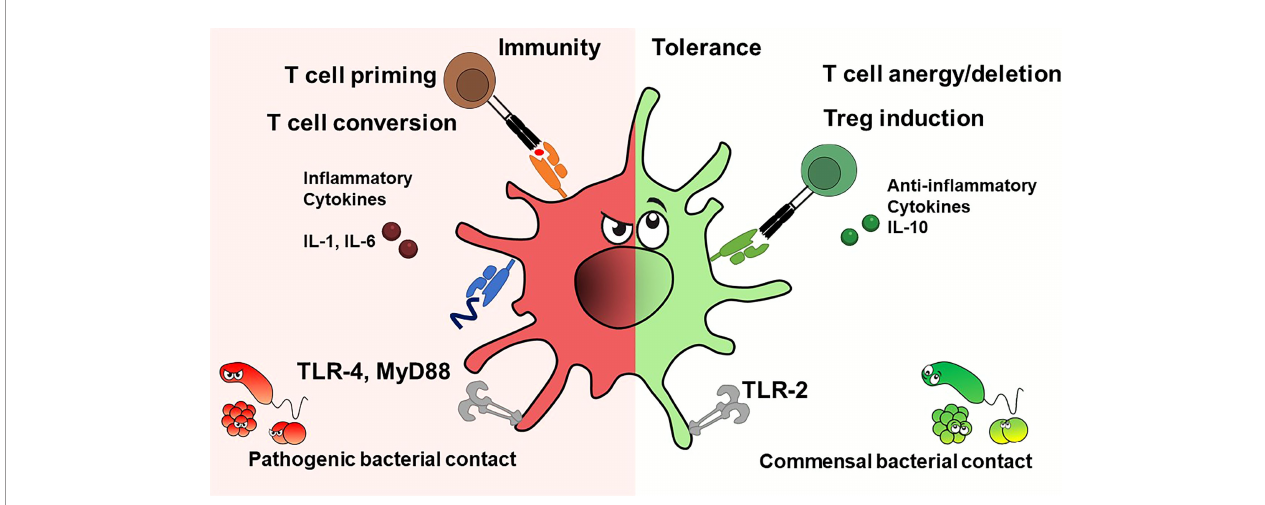
FIGURE 1 | Dendritic cells exhibit immunostimulatory or tolerogenic potential depending on the context. DC's fate depends on cytokines and pathogen contact. In fl ammatory cytokines and pathogens presenting TLR ligands promote T effector cells, while anti-in fl ammatory cytokines or interactions with commensal bacterial components produce tolerance, e.g. induce T cell anergy or deletion, or give rise to regulatory T cells.